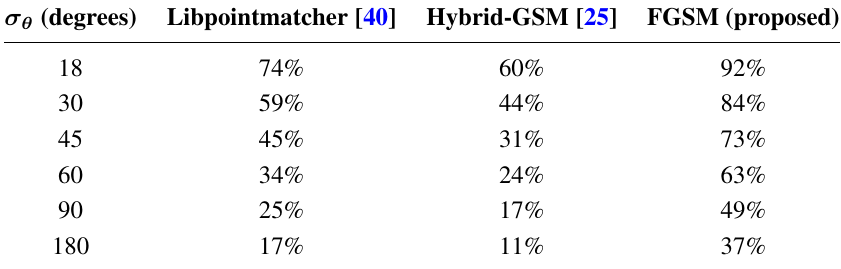
Table 2. A comparison of the proposed FGSM algorithm to previous methods in the case of rotational only error. The percentage of trials that succeeded for various standard deviations in the rotational component of the initial condition.